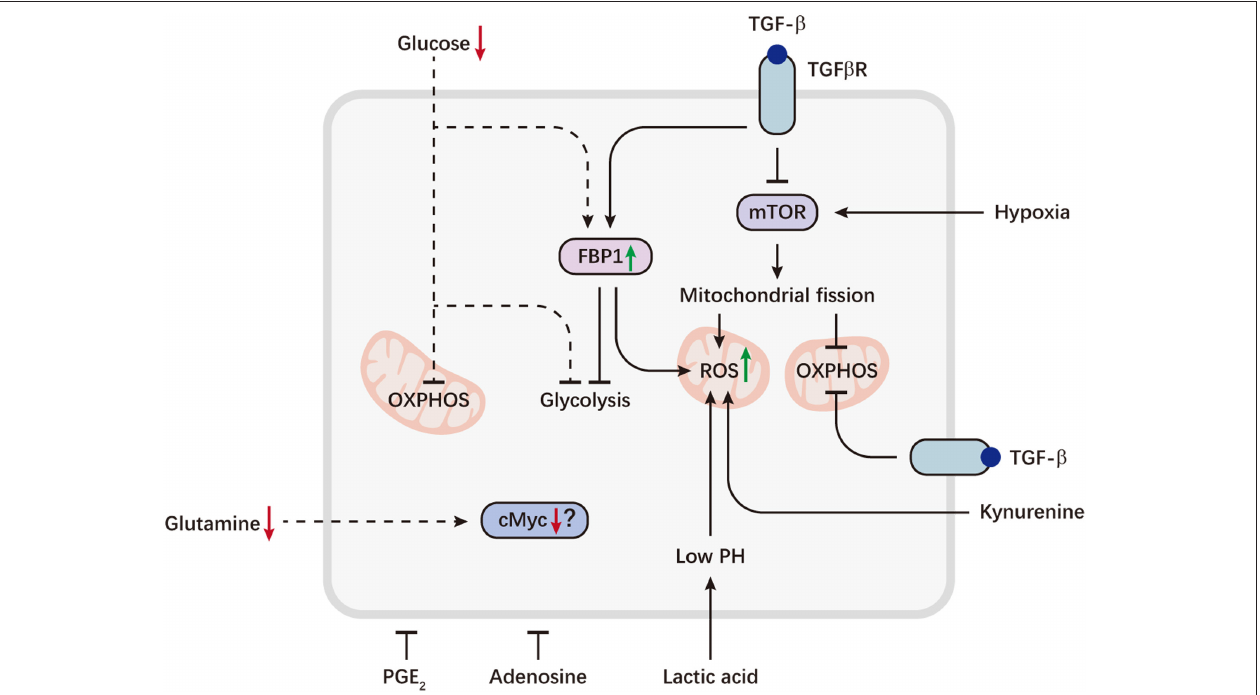
FIGURE 2 | Metabolic reprogramming of NK cells in the tumor microenvironment. Tumor cells can evade immunosurveillance by repressing NK cell metabolism. Aberrant expression of the gluconeogenic enzyme FBP1, caused by TGF β , can inhibit NK cell glycolysis and promote ROS production. TGF β also directly inhibits mTOR and drives mitochondrial dysfunction. On the other hand, sustained activation of mTOR induced by hypoxia, can lead to excessive fragmentation of mitochondria via fission, which is associated with decreased OXPHOS and increased ROS levels. Tumor-imposed metabolic restrictions may be involved in NK cell dysfunction. Depletion of glucose, a key fuel for NK cells, may induce FBP1 expression or directly restrict glucose utilization by NK cells, resulting in defective glycolysis and OXPHOS. Decreased availability of glutamine may lead to a loss of cMyc protein, thereby inhibiting NK cell metabolism. Immunosuppressive metabolites accumulated in the tumor microenvironment, including lactic acid, kynurenine, PGE 2 and adenosine, are potent inhibitors of NK cell viability and effector functions. Lactic acid causes decreased ATP synthesis and intracellular acidification, resulting in accumulation of ROS. Kynurenine can also induce NK cell apoptosis via ROS. Dashed lines indicate likely (unproven)